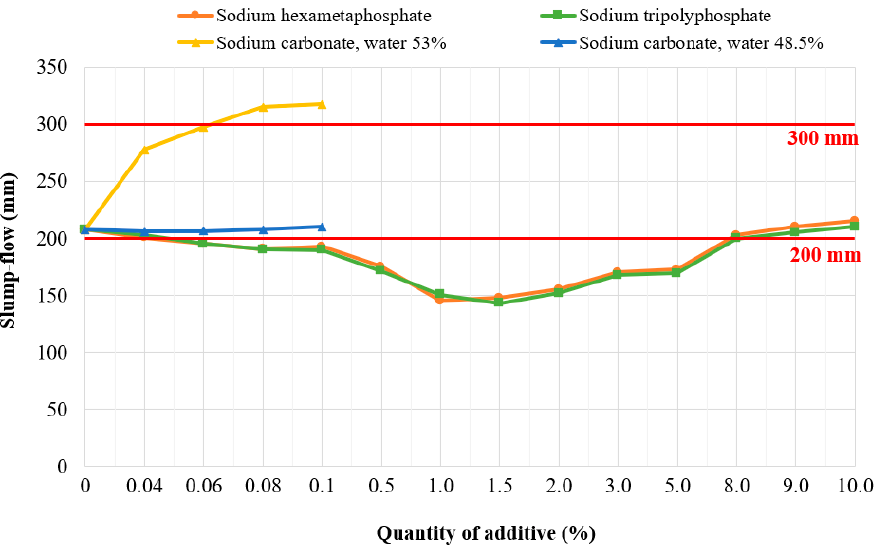
Figure 2. Verification of the effect of liquefying additives with clay soil ‘Cl’.